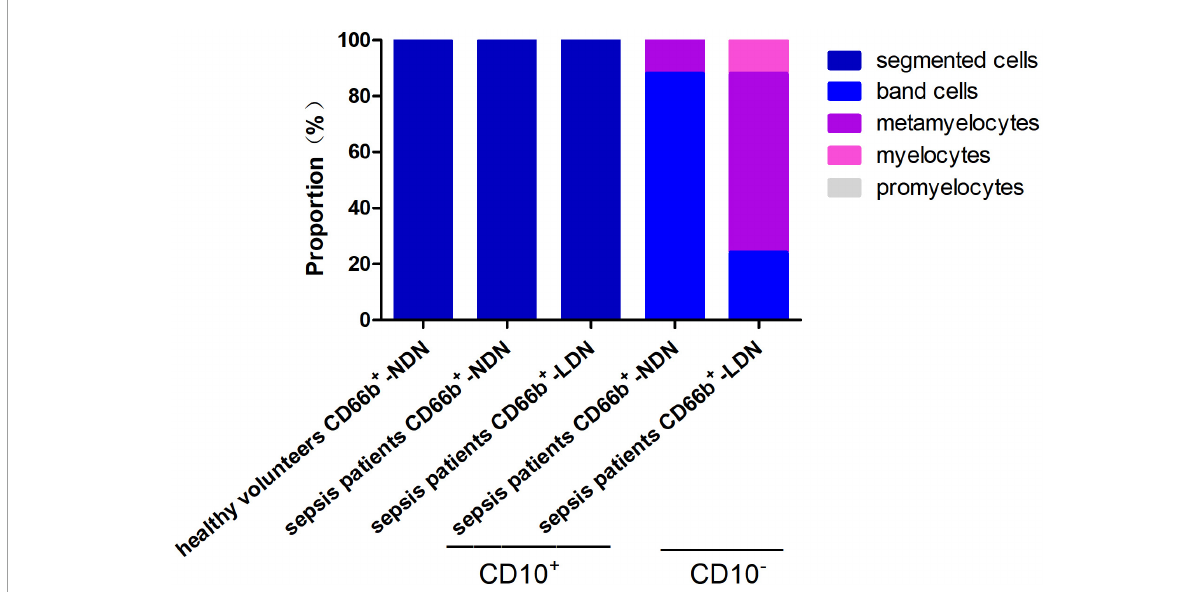
FIGURE1 Cell morphology of CD66b + CD10 + -NDN in healthy volunteers and CD66b + CD10 + -LDN/NDN in sepsis patients.